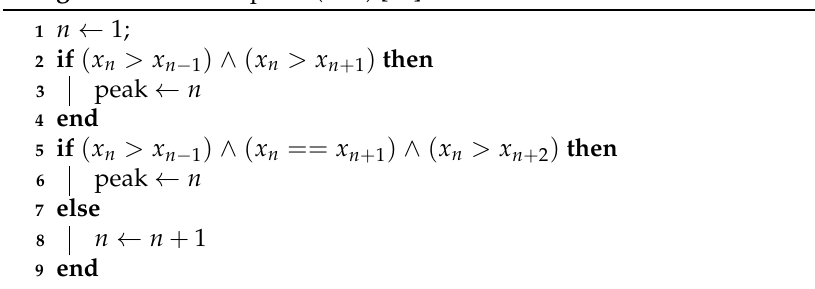
Algorithm 1: Three-point (3PT)